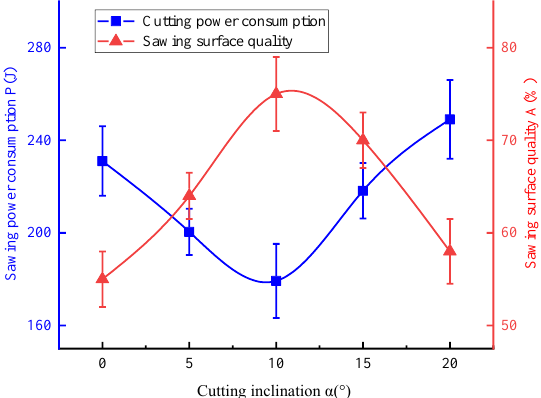
Figure 9. Sawing effect with different numbers of teeth ( Note: Branch diameter 10~12 mm; sawing speed 40 m/s; cutting inclination 10°; feeding speed 0.35 m/s; moisture content 25.0~29.9% ).